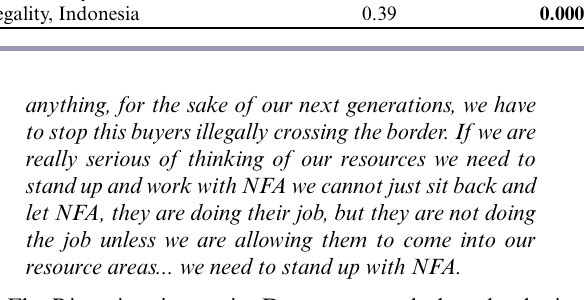
Table 5 . Nested regression models that tested whether higher level drivers explained variance in illegality in addition to that explained by lower level drivers. The models were logistic mixed effects models (all villages) and logistic regression models (Daru only). The table shows the significance of the extra variance explained as each group of explanatory variables was added to the model that included all of the previous groups, e.g., as multidimensional poverty index (MPI) was added to the model that included distance and occupation. For “All villages,” the “null” model included the village random effect.